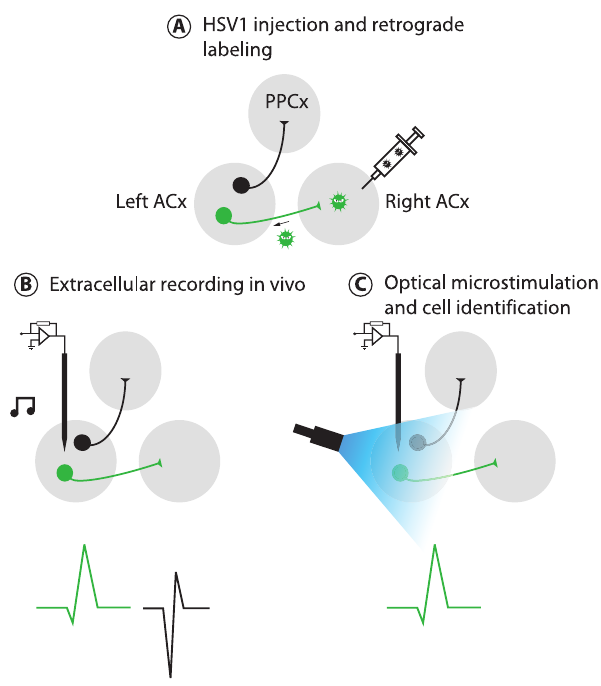
Figure 1. Identifying ChR2-tagged neurons in vivo. Photostimu- lation-assisted identification of neuronal populations: general method for identifying neuronal populations during in vivo electrophysiological recordings. (A) ChR2 expression is restricted to distinct neuronal populations using methods that allow targeting of genetically identifiable populations of neurons (more detail in text). (B) Spikes from ChR2-positive ( green ) and ChR2-negative ( black ) single units are recorded extracellularly during a normal in vivo experiment, for example in response to sound stimulation. (C) ChR2-positive units are identified on the basis of their response to a flash of blue